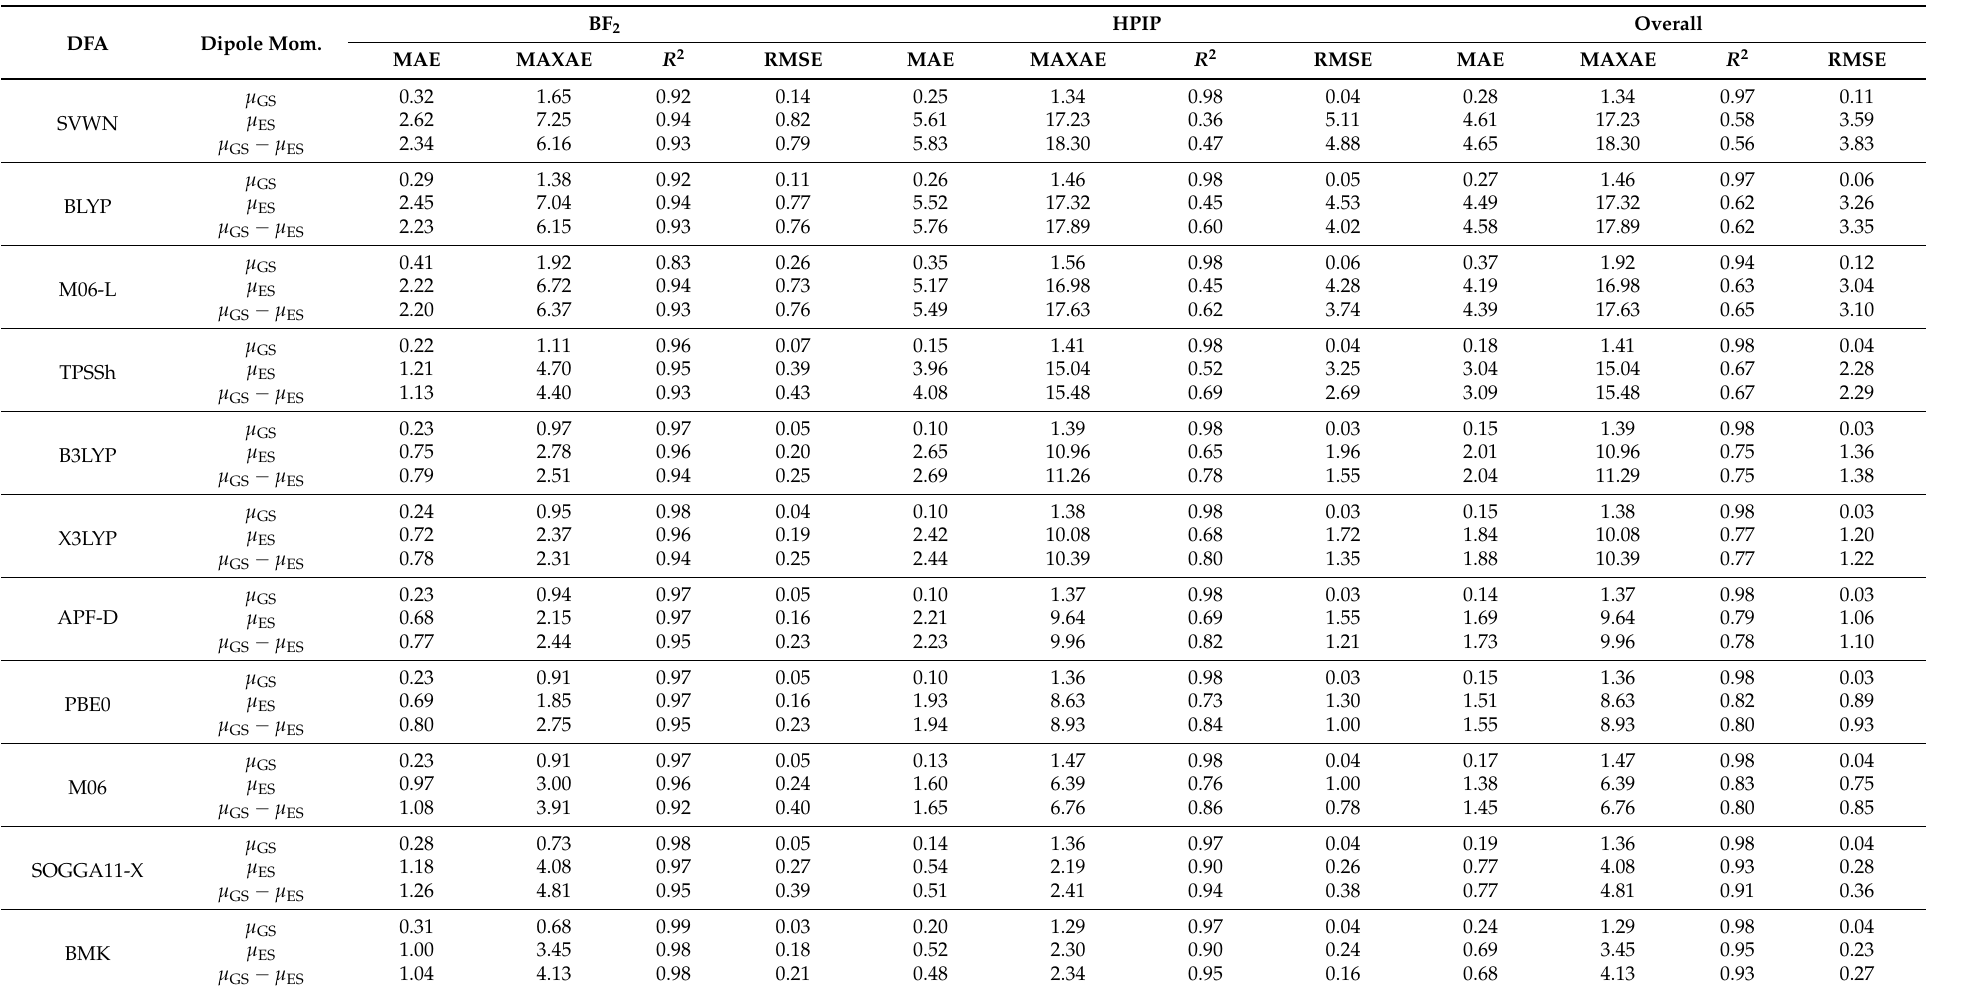
Table 2. DFA errors (in [D]) established for the dipole moments, determined with respect to CC2 results. DFA Dipole